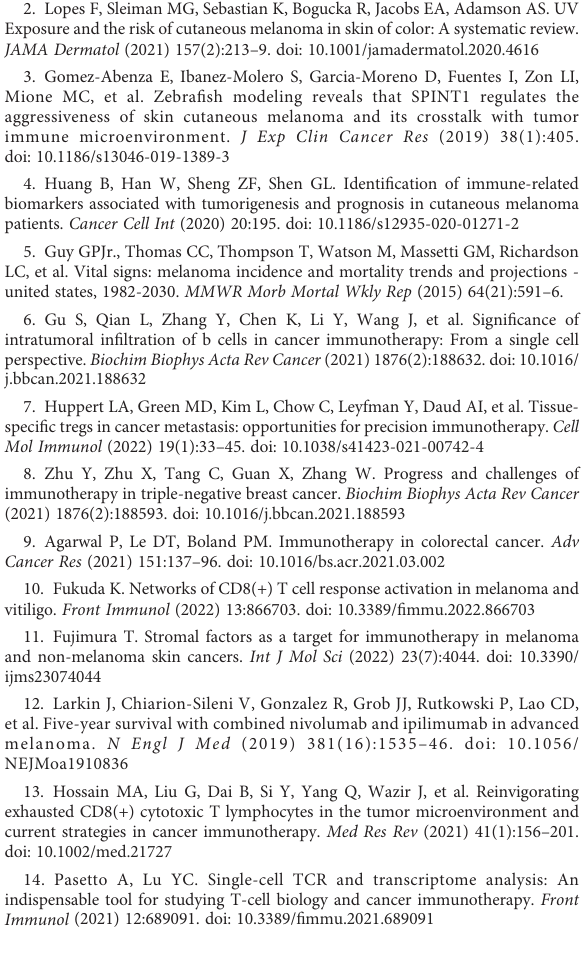
SUPPLEMENTARY FIGURE 1 Kaplan-Meier curves of 29 hub CDIGs. Kaplan-Meier survival analysis of 29 hub CDIGs in the TCGA cohort. DEGs: differentially expressed genes. SUPPLEMENTARY FIGURE 2 The expression levels of CDIGPM genes in SKCM. The expression levels of MX1, RSAD2, IRF2, GBP2, IFITM1, and OAS2 in SKCM were explored using GEPIA. Based on TCGA and GTEx data, the expression levels of MX1 and OAS2 are higher in SKCM cells. CDIGPM: CD8 + T cells-associated immune genes prognostic model. SUPPLEMENTARY FIGURE 3 Enriched KEGG gene sets in high- and low-CDIGPM groups. (A) KEGG gene sets enriched in high-CDIGPM group. (B) KEGG gene sets enriched in low-CDIGPM group. CDIGPM: CD8 + T cells-associated immune genes prognostic model. SUPPLEMENTARY FIGURE 4 Graphical